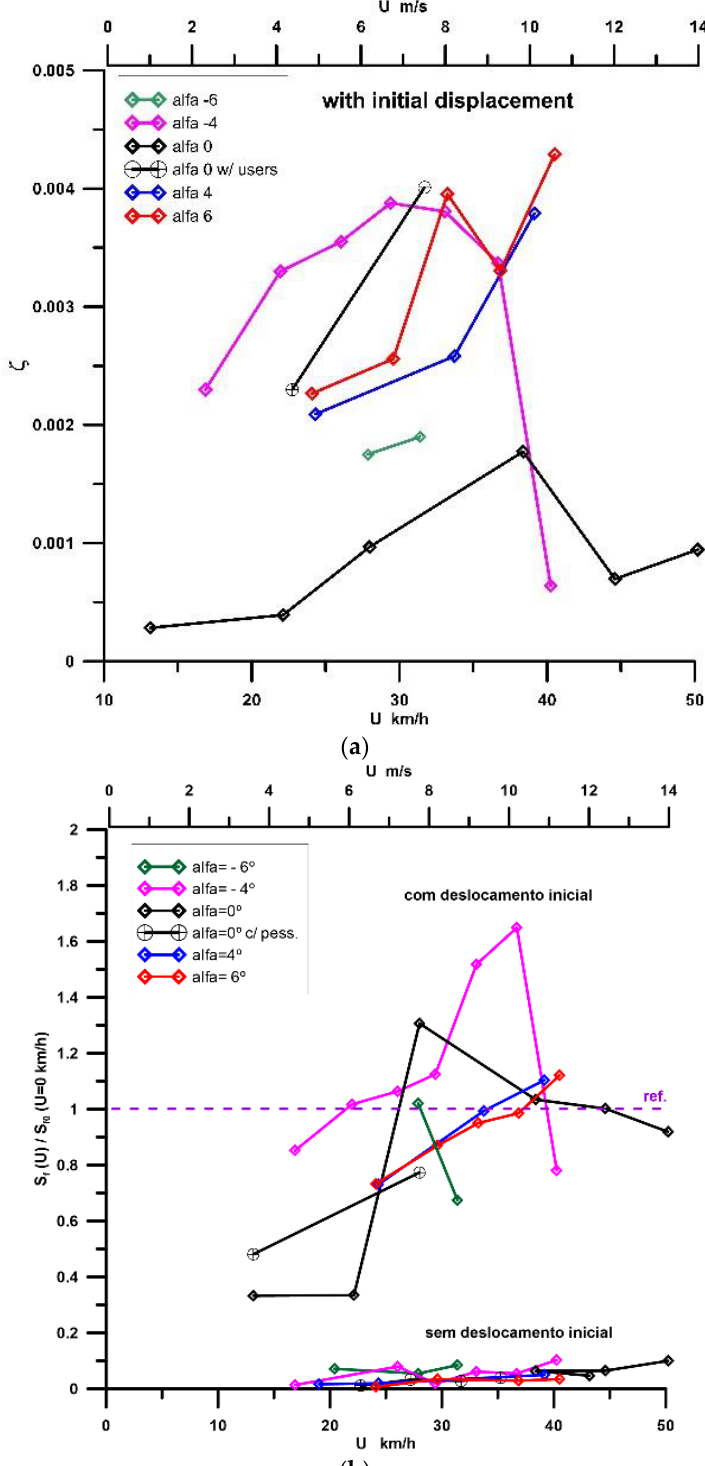
Figure 16. ( a ) Damping coefficients for swing displacement; ( b ) (Sf) pk to Sf0 ratios without and with initial displacement.